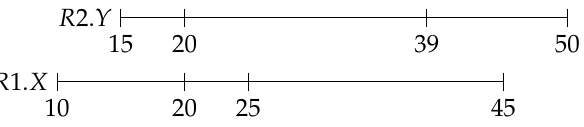
Figure 1. Equi-depth histograms of R 1. X and R 2. Y with 3 bins